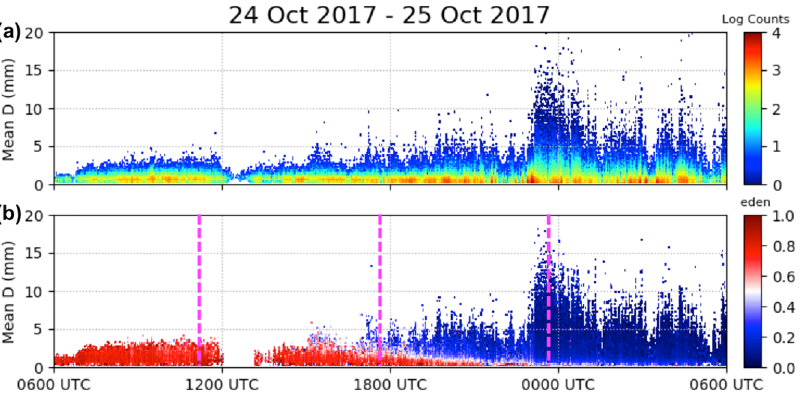
Figure 2. PIP observations during an event from 24 October 2017 at 0600 UTC to 25 October 2017 at 0600 UTC. The top panel ( a ) illustrates the PIP DSD values and the bottom panel ( b ) shows the PIP determined effective density. The dashed magenta lines highlight 1100, 1730, and 2330 UTC, which are the times used to highlight precipitation characteristics in Figure 1.